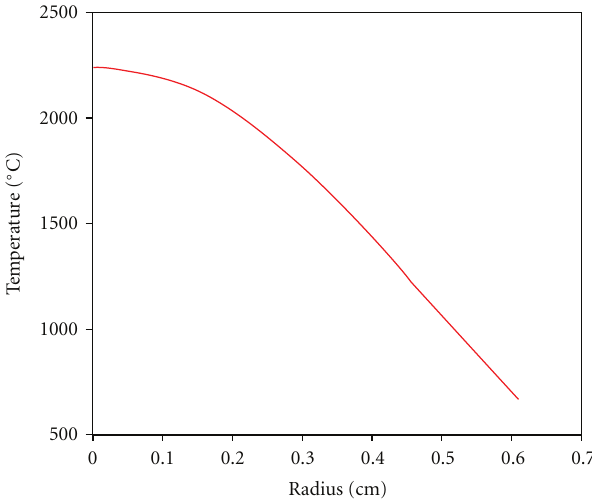
Figure 1: CANDU pellet temperature profile.